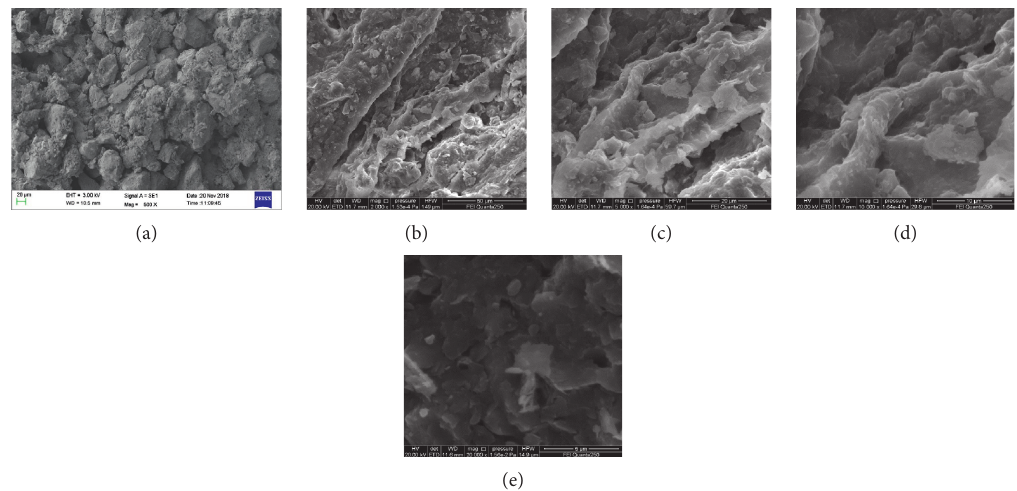
Figure 3: Distribution of the soil particle structure at the macroscale and microscale at different magnifications: (a) 500 times magnification, (b) 1000 times magnification, (c) 3000 times magnification, (d) 5000 times magnification, (e) and 10,000 times